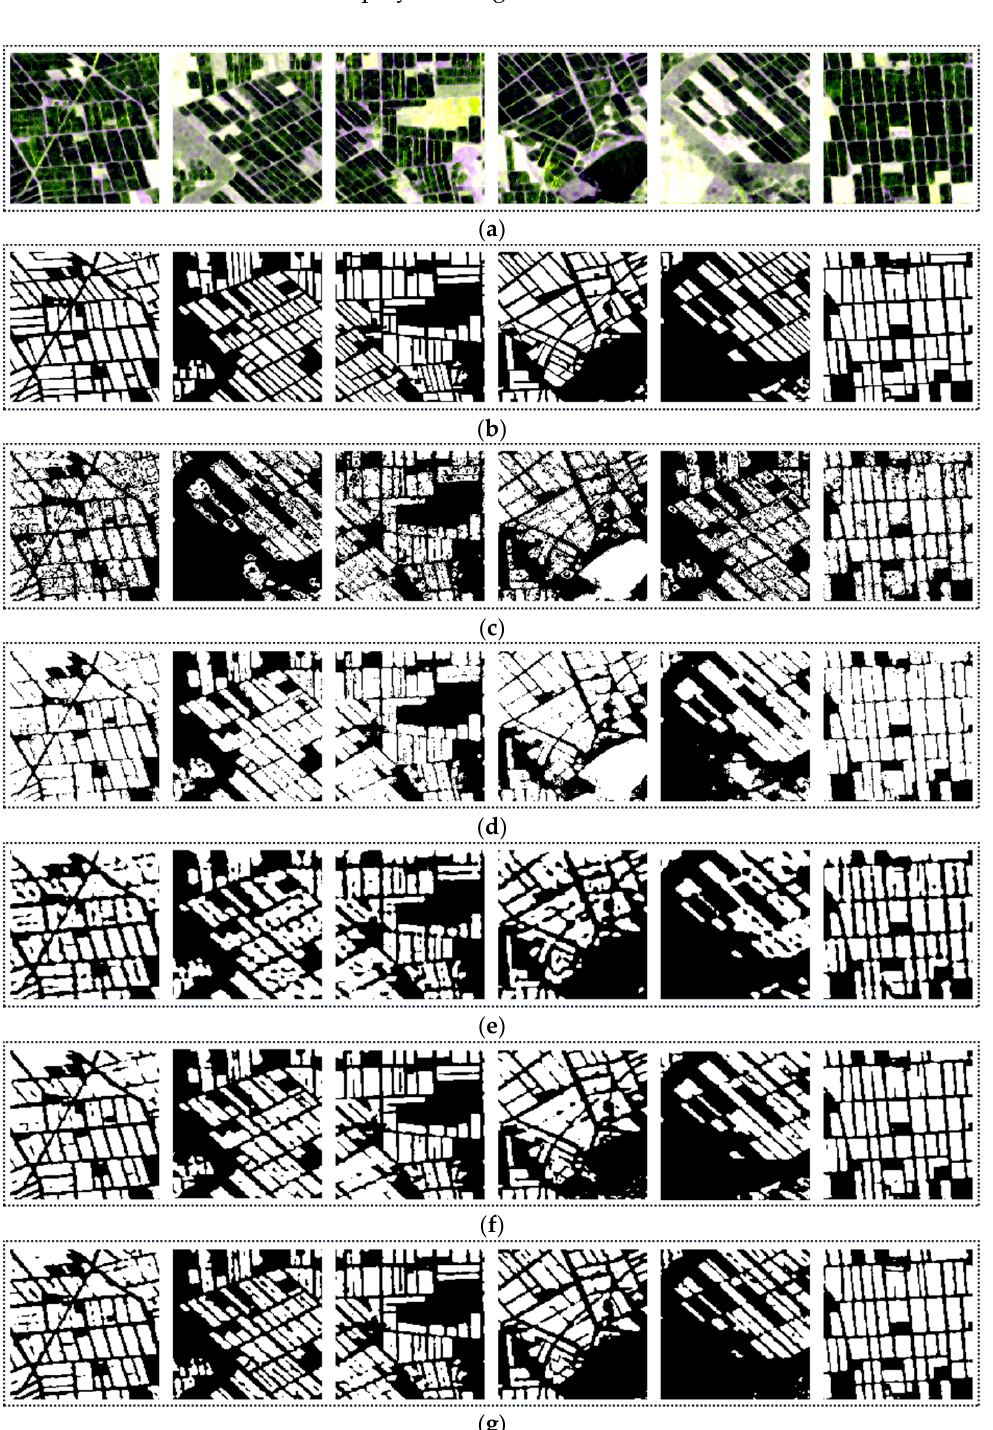
Figure 10. Classification results of the different methods for 2020. ( a ) The original SAR images. ( b ) The label images. ( c ) Wishart. ( d ) SVM. ( e ) DeepLab v3+. ( f ) U-Net. ( g ) RIAU-Net.